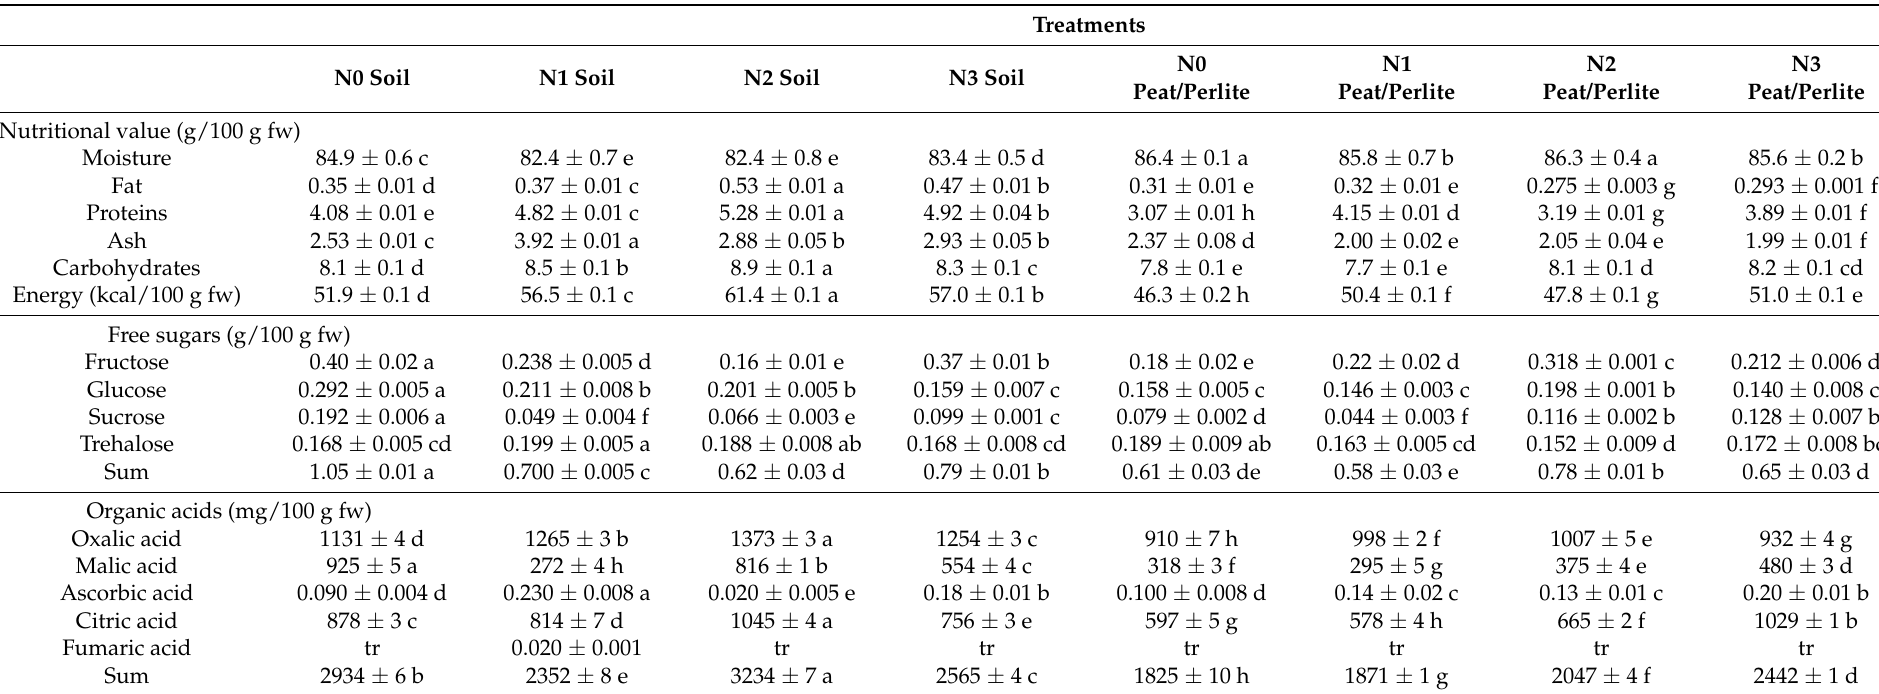
Table 1. Nutritional value and hydrophilic compounds of Centaurea raphanina spp. mixta plants in relation to nitrogen fertilization and growth substrate (mean ±